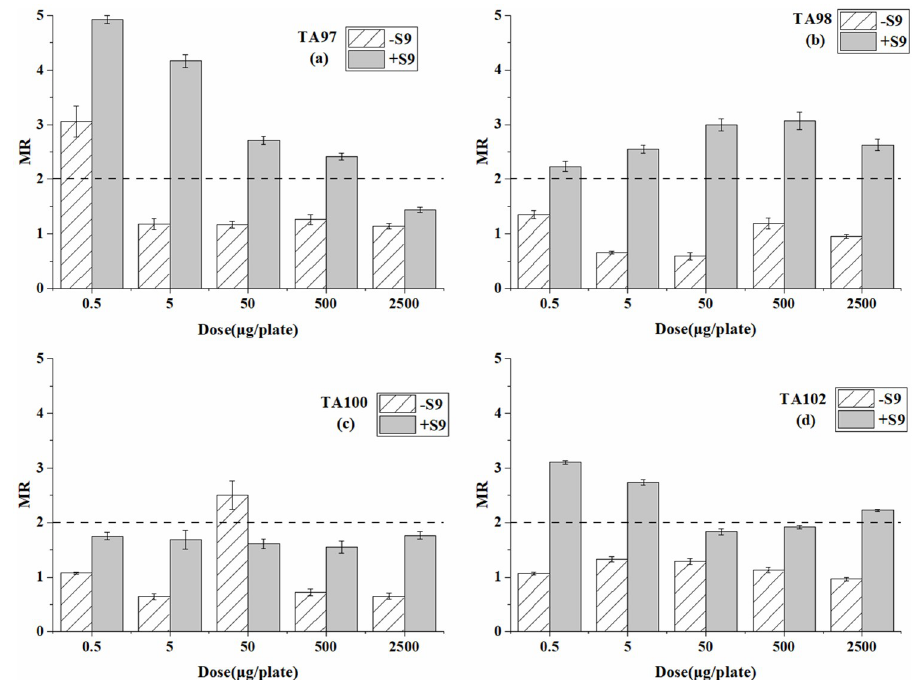
Fig 1. Mutagenesis of BP-6 to four strains in the presence and absence of S9 liver extract; (a) TA97 strain; (b) TA98 strain; (c) TA100 strain; (d) TA102 strain. The mutation ratio (MR) is the average ratio ( ± SE) from three parallel plates.